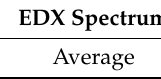
Table 1. Atomic percentage of Co, Mn, and Ge elemental composition in Co 2 MnGe glass- coated microwires. EDX Spectrum Co (at. %) Mn (at. %) Ge (at. %) Average 53 ± 2 22 ± 2 25 ±